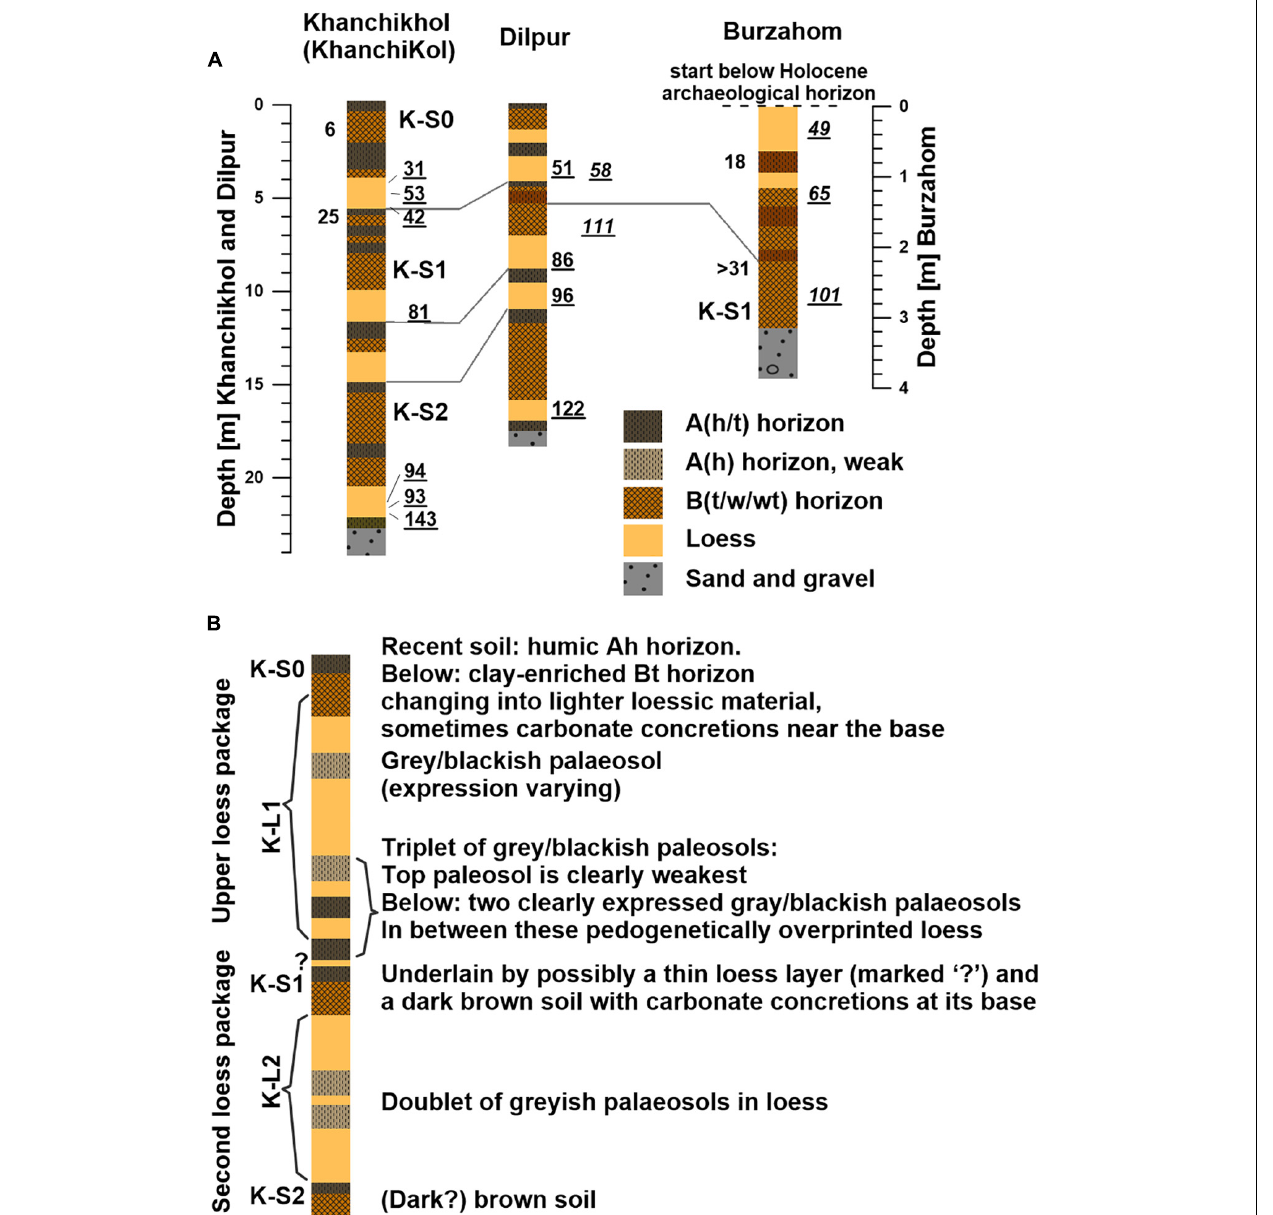
FIGURE 3 | (A) Comparison of selected loess-paleosol sections which have been dated. Ages are rounded and given in ka. Stratigraphic positions are indicated as good as possible, correlation to stratigraphic unit is correct but the exact positioning is only indicative here. Logs are summarized and simplified from Kusumgar et al. (1986), Bronger et al. (1987a), and Singhvi et al. (1987). Thermoluminescence ages are plotted right of section logs, here after Rendell and Townsend (1988; bold and underlined), and from Singhvi et al. (1987; bold, underlined and italic). 14 C ages from Kusumgar et al. (1986) are included left of the stratigraphic columns. Note that other dates are available but cannot be placed in the stratigraphies unambiguously. Correlations are after Bronger et al. (1987a) and Singhvi et al. (1987) and Gupta et al. (1991). Note that 14 C ages are systematically younger than thermoluminescence ages. Please see the here introduced nomenclature for loess and palaeosol sequences as K-S0 to K-S2 and K-L1 to K-L2. At the Himalayan Flank only the K-S1 is present, while older loess is described from the Valley toward the Pir-Panjal flank. (B) Generalized stratigraphy of the upper/younger Kashmir loess–palaeosol sequences across the Kashmir Valley. At some localities, loess below these two packages is outcropping, but we can at this point not describe a general pattern. Below the here generalized stratigraphy, the stratigraphy is less clear to us. Several (2 at least, possibly more) well expressed paleosols follow. These are not always separated by loessy material. We name the Soils K-S0 (recent soil) to K-S2 (second thick brows soil) and the upper two loess units K-L1 and K-L2. These are descriptive terms here and are no indication of time or glacial/interglacial cycles due to a lack of reliable chronology. Please note the maker triplet of soils in (B) , which sometimes represents the upper part of an amalgamated K-S1 pedocomplex, and sometimes is separated by loess layers, see also Figures 4D,E .